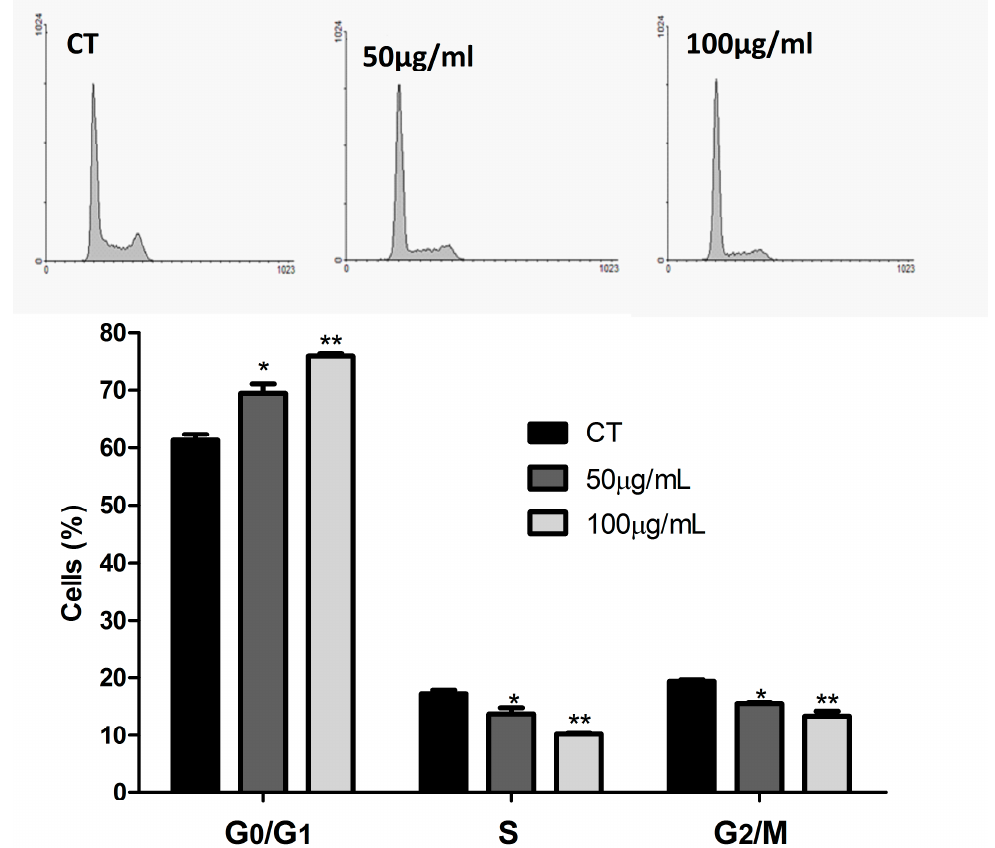
Figure 2. Effect of açai seed extract (ASE) on cell cycle progression in A549 cells after 48 h of treatment. The phases of the cell cycle are illustrated at control (CT) and treated with 50 and 100 µ g/mL of ASE. The experiment is expressed as mean ± standard deviation. Significant differences between untreated cells (CT) and treated with açai seed extract (ESA) (50–100 µ g/mL) were compared by one-way analysis of variance (ANOVA) followed by Tukey multiple comparison post-hoc test (* p < 0.05. ** p < 0.01).